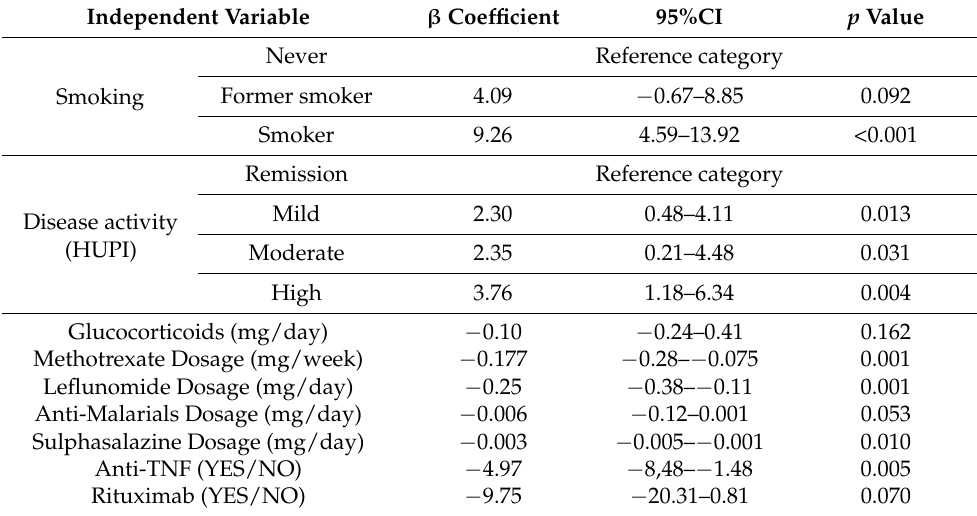
Table 3. Multivariate analysis showing variables associated with the evolution of anti-CCP2 titers. Adjusted model with disease activity assessed by HUPI index.